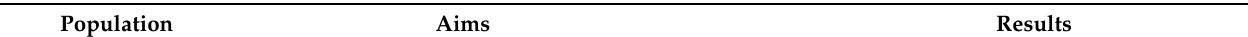
Table 1. Data extracted with the